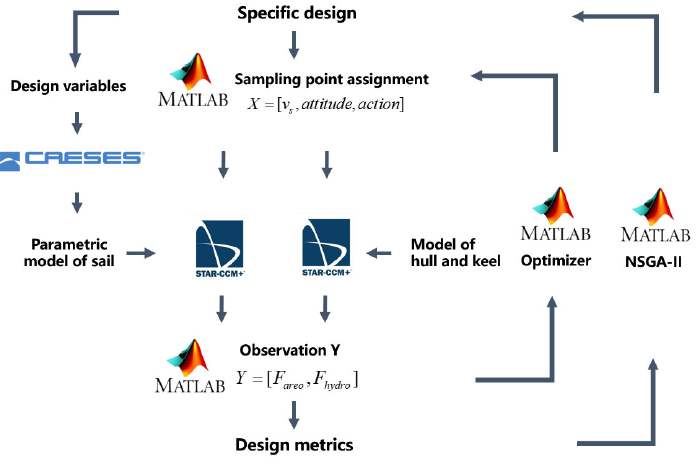
Figure 9. Software interaction for optimisation processes.